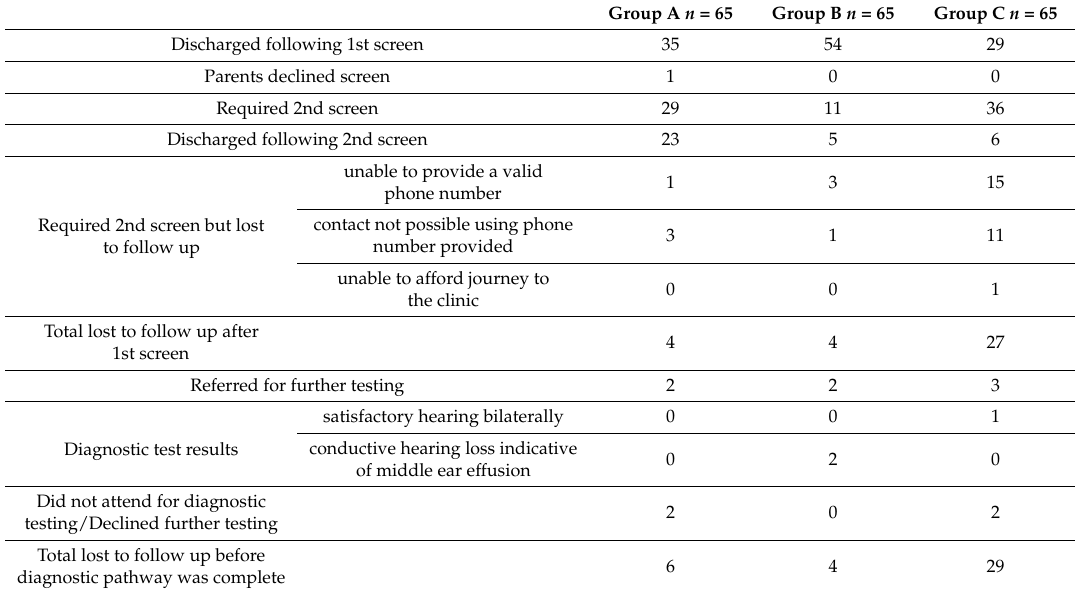
Table 1. Outcomes for infants going through the hearing screening